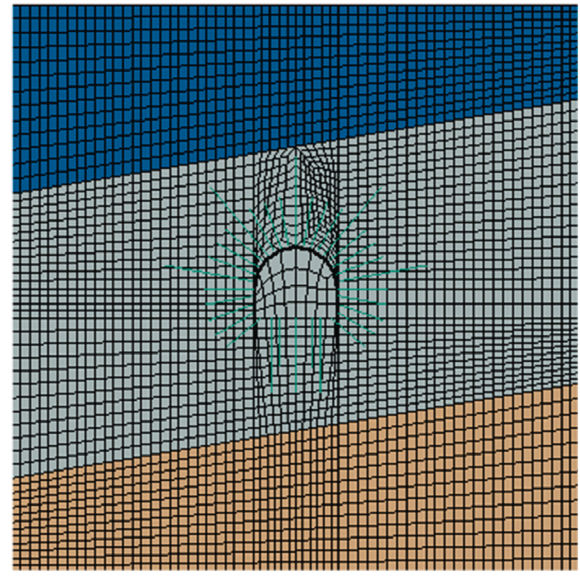
Figure 2: Grid diagram of a numerical